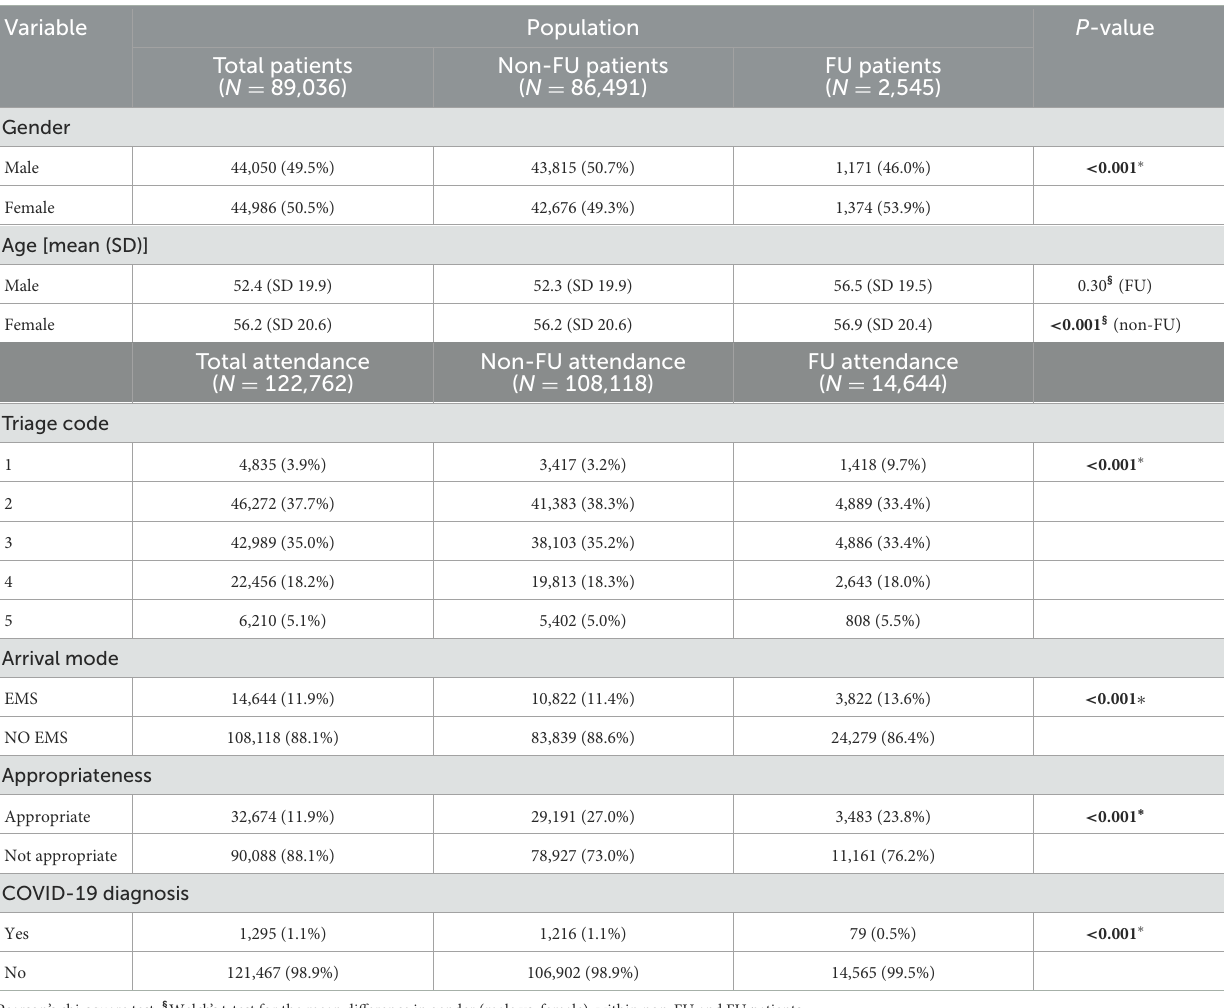
TABLE 2 Characteristics of ED users and attendance, stratifying by user demographic variables and ED attendance parameters.